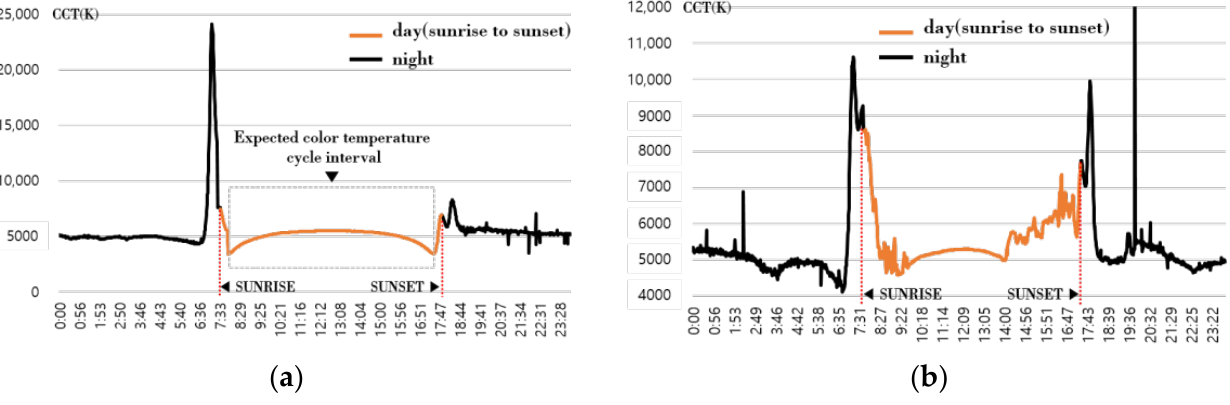
Figure 1. Color temperature cycle from sunrise to sunset. ( a ) Example of precise color temperature distribution (31 December 2020), ( b ) Example of unclear color temperature distribution (29 January 2021).